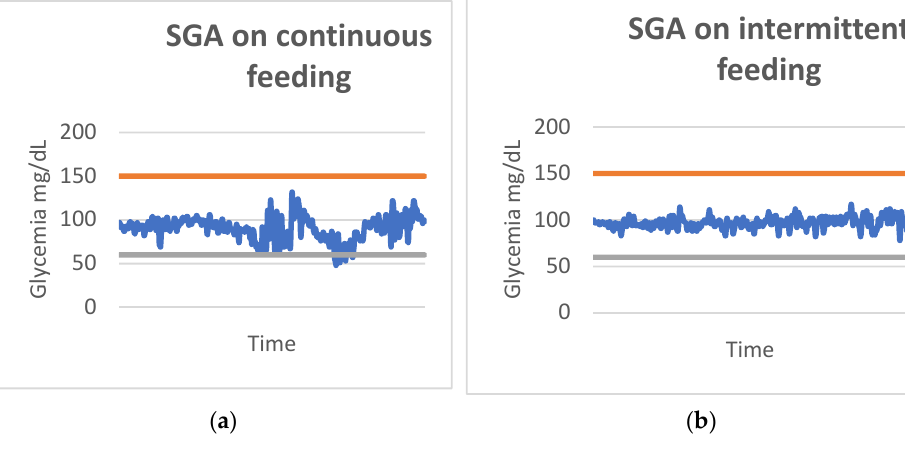
Figure 9. Glycemic trend in SGA for continuous ( a ) and intermittent ( b ) feeding. SGA, small for gestational age. Reference range for lower (grey line) and higher (red line) blood glucose values, are depicted.